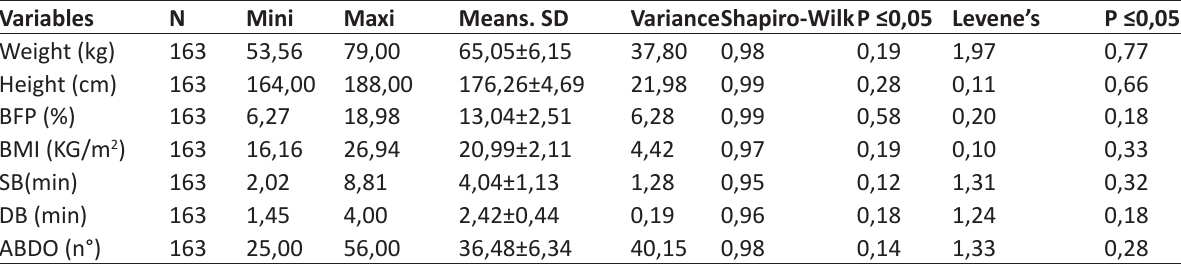
Table 2: Presents the Results of regression analyses relating Strength ABDO and the anthropometrics variables used in the current study.